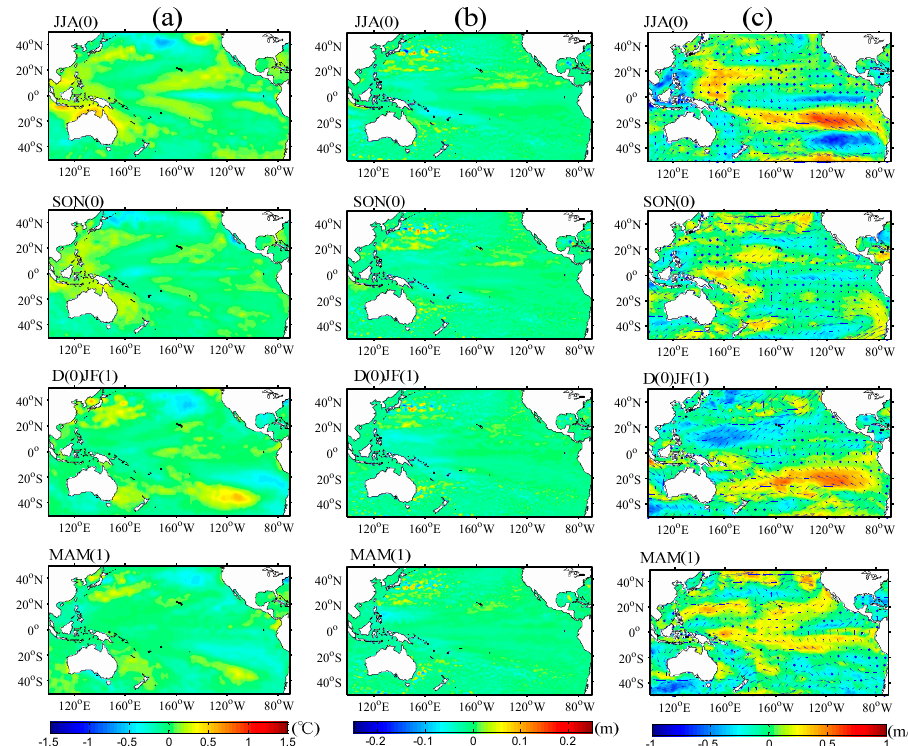
Figure 8. Seasonally evolving patterns of ( a ) SST; ( b ) sea level; and ( c ) SSW anomalies from JJA(0) to MAM(1) regressed with the PC of the second SEOF mode of precipitation.